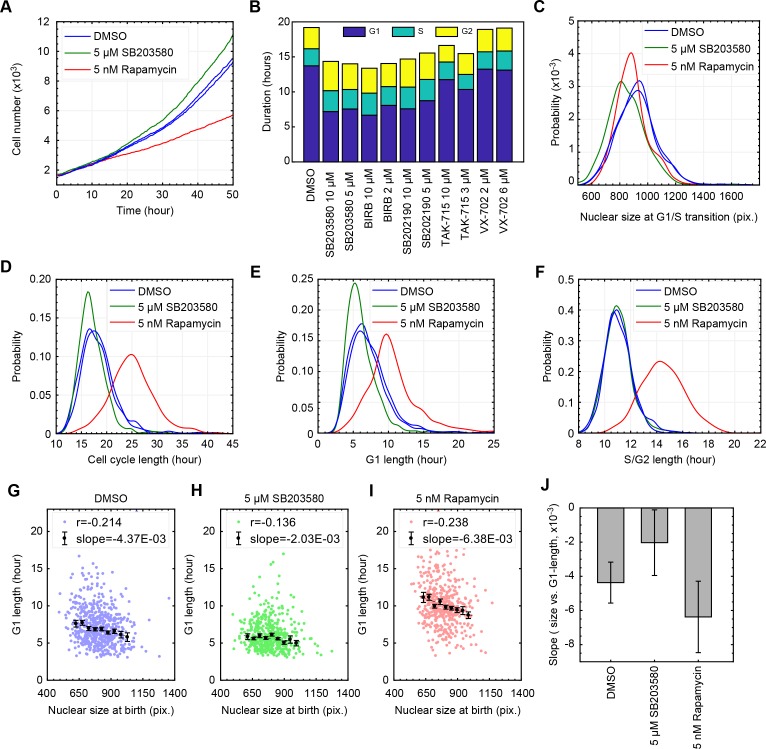
Inhibition of p38 weakens the coordination of cell size and G1 length at a single-cell level.(A) Live cells subject to p38 inhibition (SB203580) or to mTORC1 inhibition (rapamycin) were followed with time-lapse microscopy to monitor proliferation over a period of 50 hr. mTOR inhibition significantly slowed rates of proliferation, while p38 inhibition increased rates of proliferation. (B) As an alternative method to assay cell cycle lengths, populations of cells were treated with p38 inhibitors and samples were fixed every 20 hr over a period of 3 days (see Materials and methods -Estimation of cell proliferation durations and growth rate from bulk measurements). Proportion of cells in the different cell cycle stages, in each of the collected samples, were calculated based on the cell cycle indicators depicted in Figure 1B. Consistently, p38 inhibitors accelerate proliferation by shortening the duration of G1 but not the durations of S or G2 (also see Figure 3—figure supplement 3). The meta data and source code used for this cell cycle analysis is presented in Figure 3—source data 1. (C–F) Live cells were imaged by time-lapse microscopy for a period of 50 hr to obtain growth trajectories of single cells over the course of their entire cell cycle. Computer generated image processing and cell tracking were performed, as described in Materials and methods - Automated lineage tracking and analysis, to obtain single cell growth curves. Nuclear size was used as a proxy of cell size, as has been validated in Ginzberg et al., 2017. Cells that were successfully tracked throughout their entire cell cycle were collected to calculate the cell cycle durations and cell size dynamics. (G–I) Scatterplots displaying relationship between nuclear size at birth and G1 duration for individual cells that are subject to chemical inhibition of p38 (H), chemical inhibition of mTOR (I), and a control population treated with DMSO (G). Every single point corresponds to the birth size and G1 length of a single live cell that was followed by time-lapse microscopy. Also shown are means and errorbars (SEM) of average G1 length calculated for different cell size bins. The dashed line shows the result of linear regression with the binned data. (J) Slopes obtained by the linear regression shown in (G–I) Error bars indicate 95% confidence bounds. The results shown here are representative of two independent experiments. The single-cell tracking data from the live-cell imaging experiments and the source code for analysis and visualization of the results is presented in Figure 3—source data 2.10.7554/eLife.26947.022Figure 3—source data 1.Estimation of cell cycle duration and growth rate from bulk measurements of fixed cell populations.10.7554/eLife.26947.023Figure 3—source data 2.Measurements of single-cell dynamics of cell size captured by live-cell imaging.